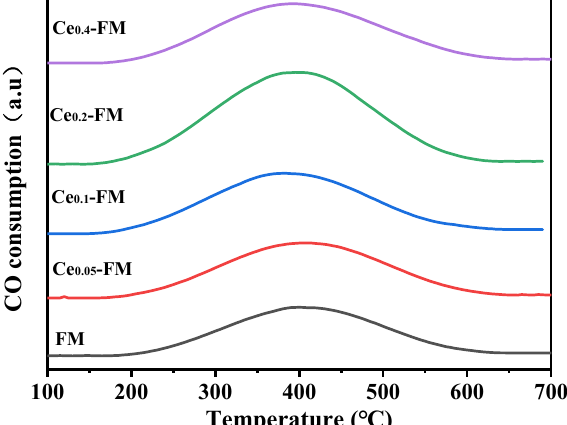
Figure 4. CO-TPR profiles of Ce x -MF catalysts.